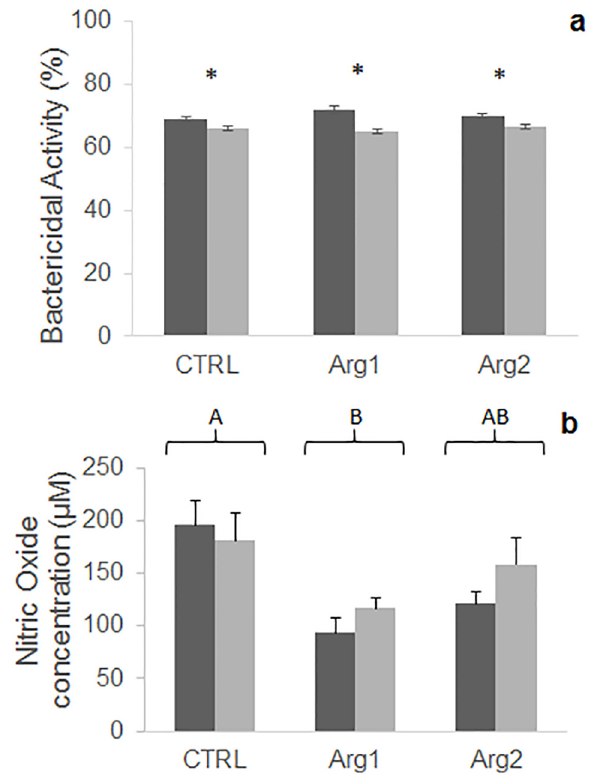
Fig 3. Bactericidal activity (a) and nitric oxide content (b) in plasma of European sea bass fed different diets for 15 (black columns) or 29 (grey columns) days. Values represent means ± SEM (n = 6). Asterisks denote differences attributed to feeding time within each diet. Different capital letters stand for statistically significant differences between diets regardless of feeding time (Two-way ANOVA; P <